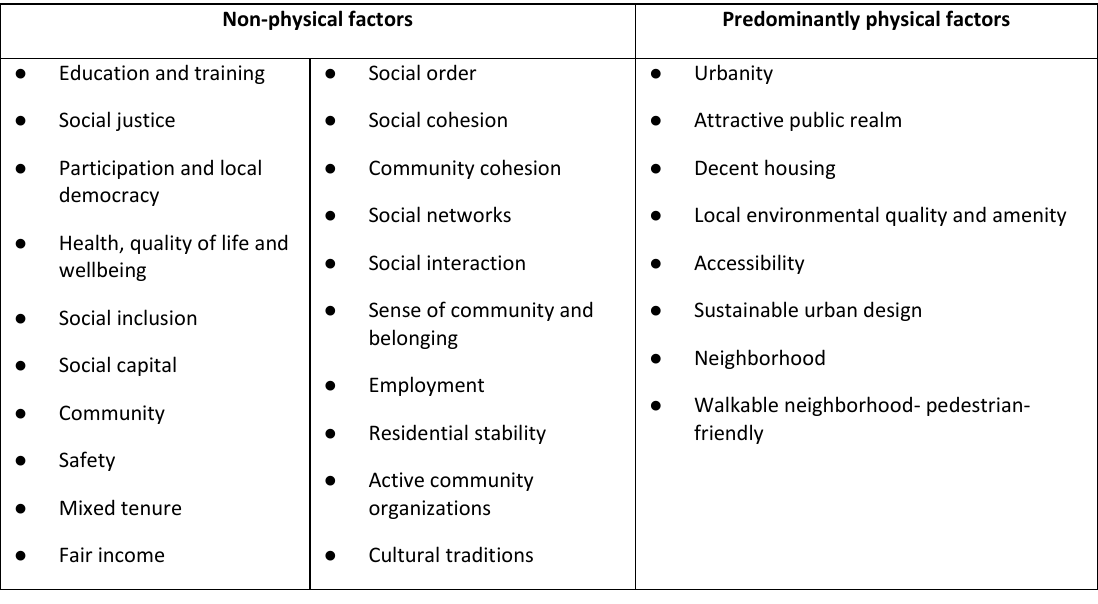
Table 1 Urban social sustainability – contributory factors as identified in a literature review (Dempsey et al., 2011,